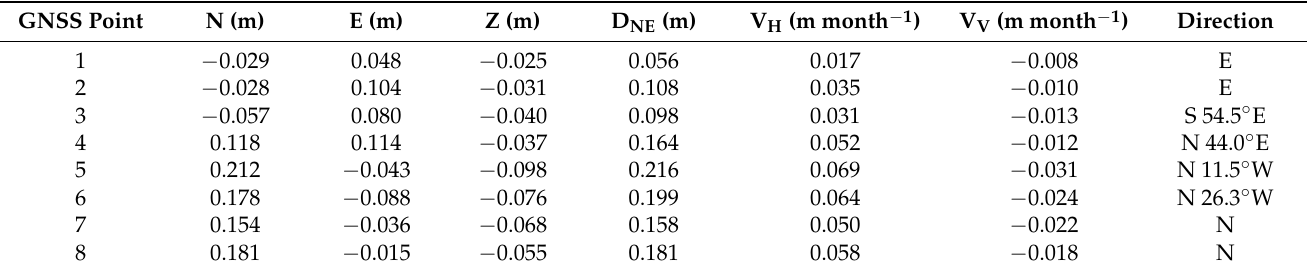
Table 4. Summary of effective N, E, and Z-axis displacements of GNSS points in Victoria, displaying the direction and speed of each horizontal and vertical